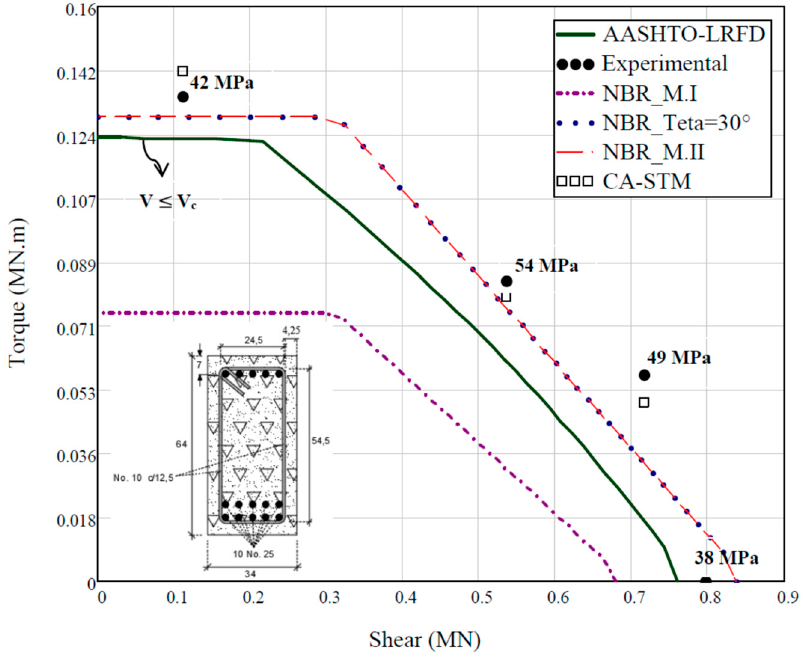
Figure 4. Interaction torque–shear curves for RC beams from Series 1. In Figure 4, the “ • ” symbols represent the experimental results for each beam. The dashed line “ − − ” represents the interaction curve optimized from the NBR 6118 provisions, considering the angle of the concrete struts ( θ ) variable according to model II to compute the shear strength of the cross-section. The dotted line “ · · · ” represents the interaction curve optimized according to model II from NBR 6118, considering θ = 30 ◦ . The dash-dotted line “ − · − ” represents the interaction curve optimized from model I with θ = 45 ◦ . The continuous line represents the interaction curve computed from optimization procedures according to AASHTO LRFD provisions. Finally, the points with squared symbols represents the theoretical results from the CA-STM.